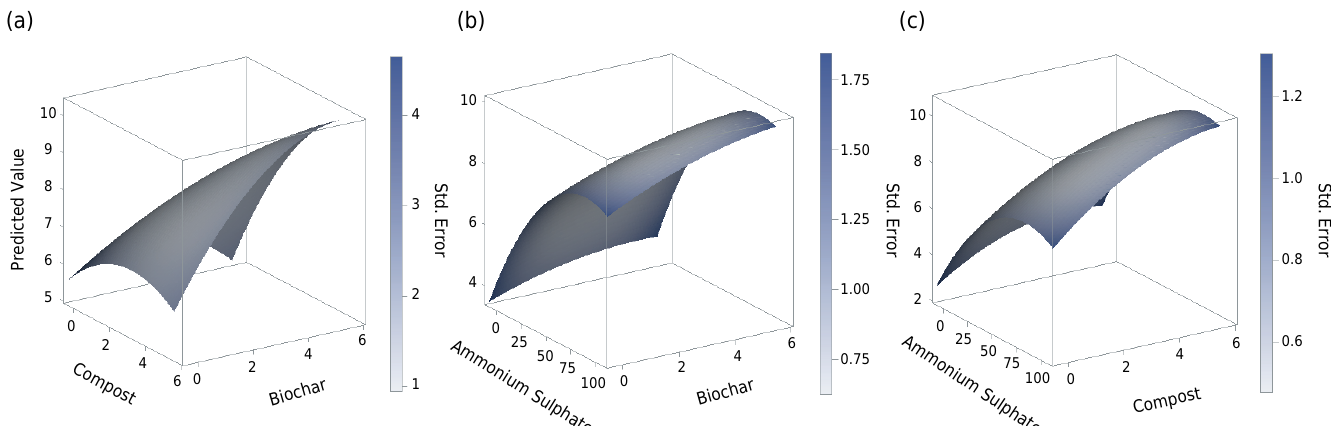
Figure 5. The NL (kg ha -1 N) response to independent variable: (a) biochar (t ha -1 ) and compost (t ha -1 ); (b) biochar (t ha -1 ) and ammonium sulphate (kg ha -1 ); (c) compost (t ha -1 ) and ammonium sulphate (kg ha -1